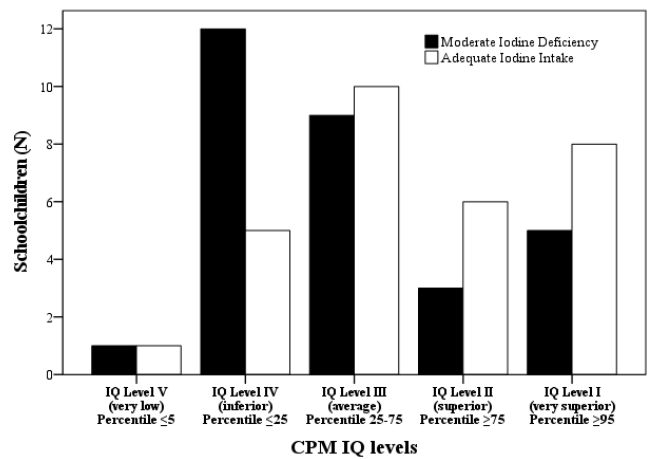
Figure 3. Raven ´ s Colored Progressive Matrices (CPM) IQ for Moderate Iodine Deficiency (UIC Figure 3. Raven´s Colored Progressive Matrices (CPM) IQ for Moderate Iodine Deficiency (UIC 20 – 20–49 µ g/L, n = 30) and Adequate Iodine Intake (UIC 100–199 µ g/L, n = 30) 49 μ g/L, n = 30) and Adequate Iodine Intake (UIC 100 – 199 μ g/L, n = 30) subgroups. 3.3.2. Wechsler Intelligence Scale for Children — 3rd Edition (WISC-III) Full-Scale IQ differed significantly between the subgroups with moderate iodine de- ficiency and adequate iodine intake (mean 86.67 vs. 101.80, t(58) = 2.568, p = 0.013). School- children with moderate iodine deficiency had 15% lower scores, and an inferior difference of 15.13 IQ points, when compared with the adequate iodine intake group (Figure 4).